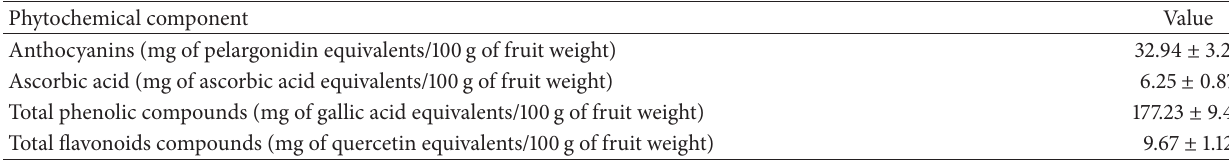
Table 2: Phytochemical components of C. uvifera